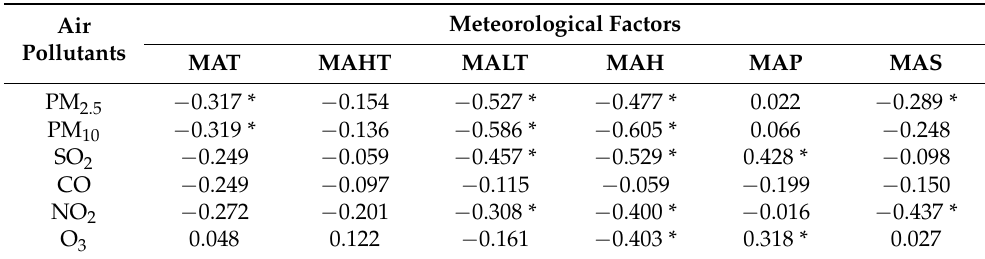
Table 4. CCF coefficients between the prewhitened air pollutants concentration and meteorological factors residuals series at lag 0 between 2015 and